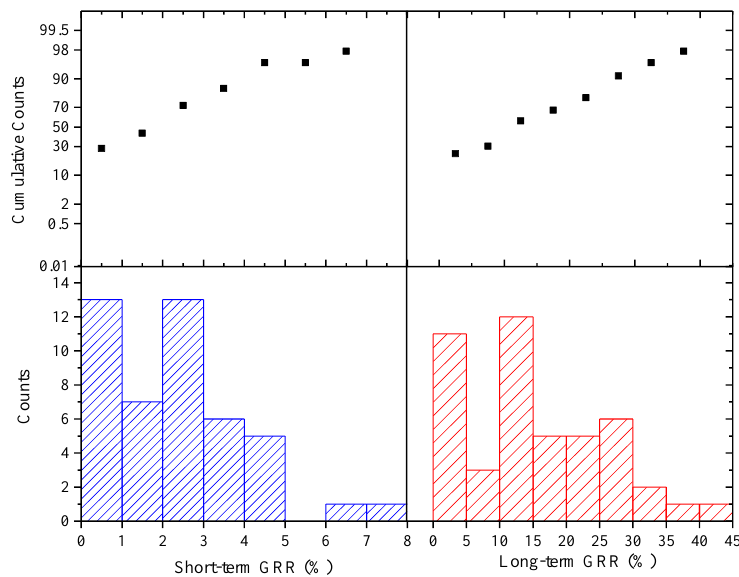
Figure 6. Histograms of GRR s of 46 runs in short-term and long-term gas productions with geomechanics.